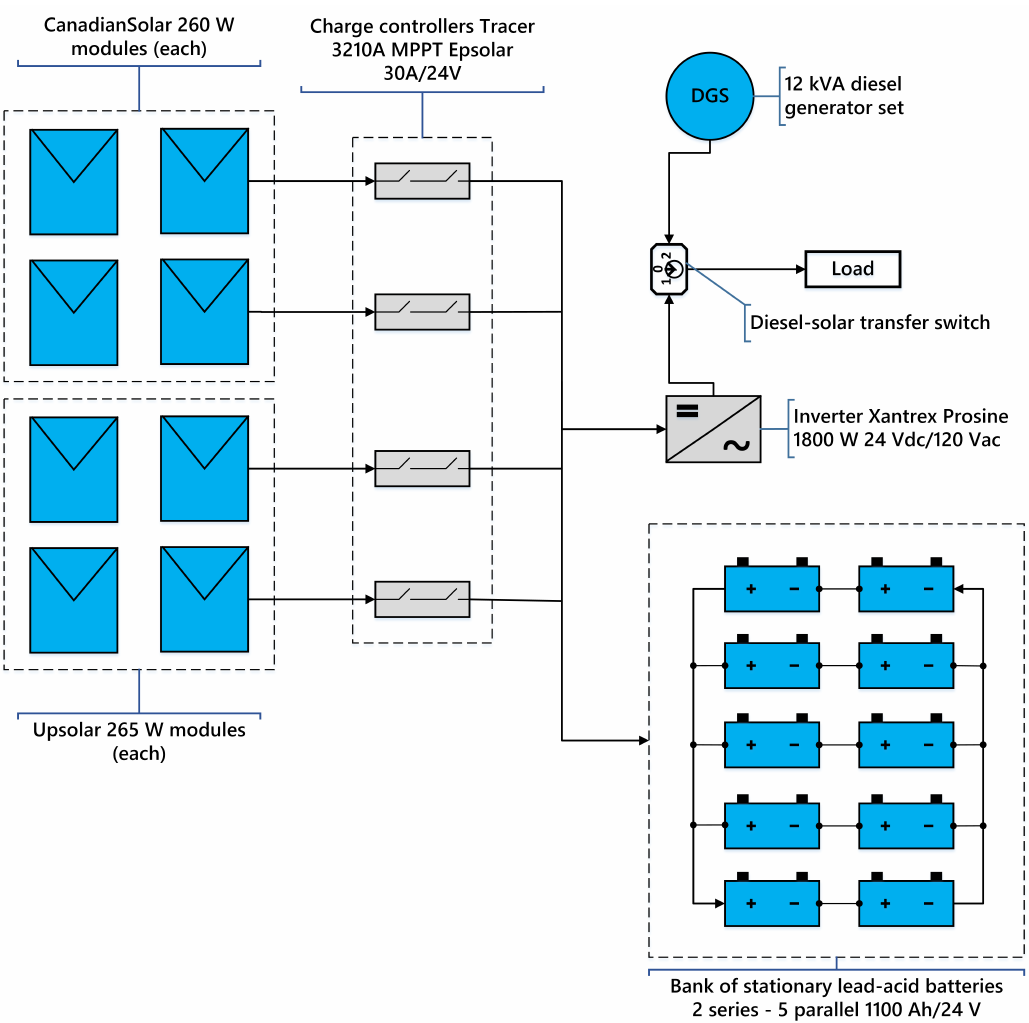
Figure 9. Mixed topology (series/parallel) adopted in hybrid energy systems